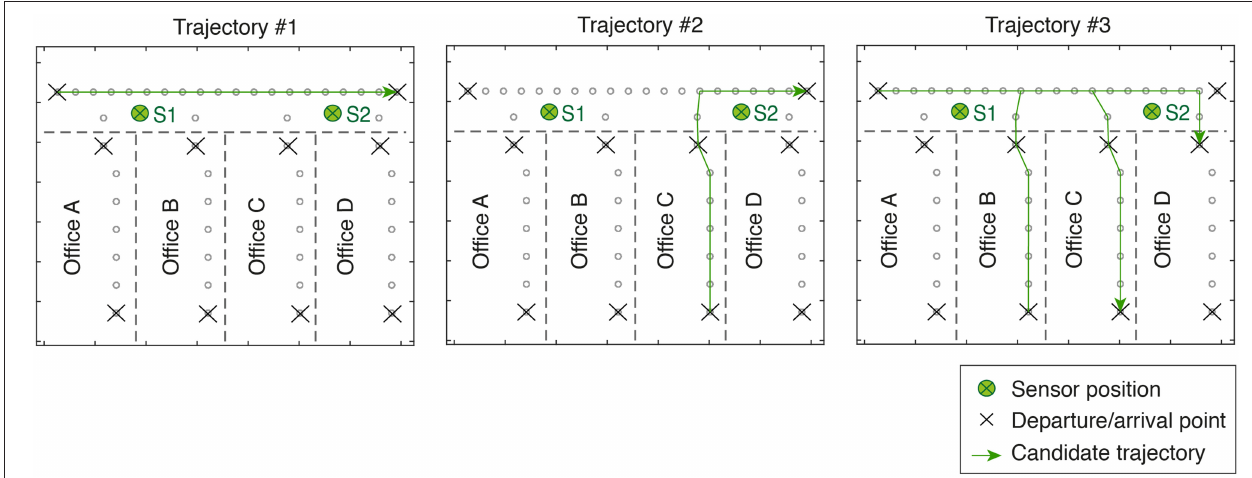
FIGURE 13 | Candidate trajectories that result from identification for each tested trajectory (see Figure 4 ). EDMF and sequential analysis (see Figure 3 ) identify accurately and precisely tested trajectories. Four candidate trajectories remain after completing trajectory #3.